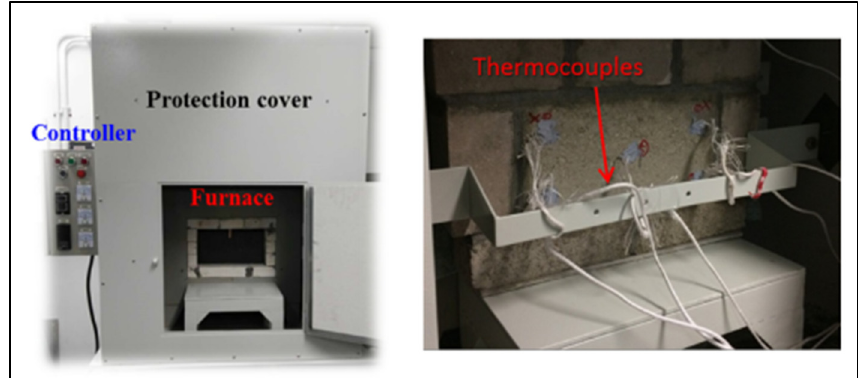
Figure 16. Specially designed furnace and specimen installation for lab ‐ scale fire test.